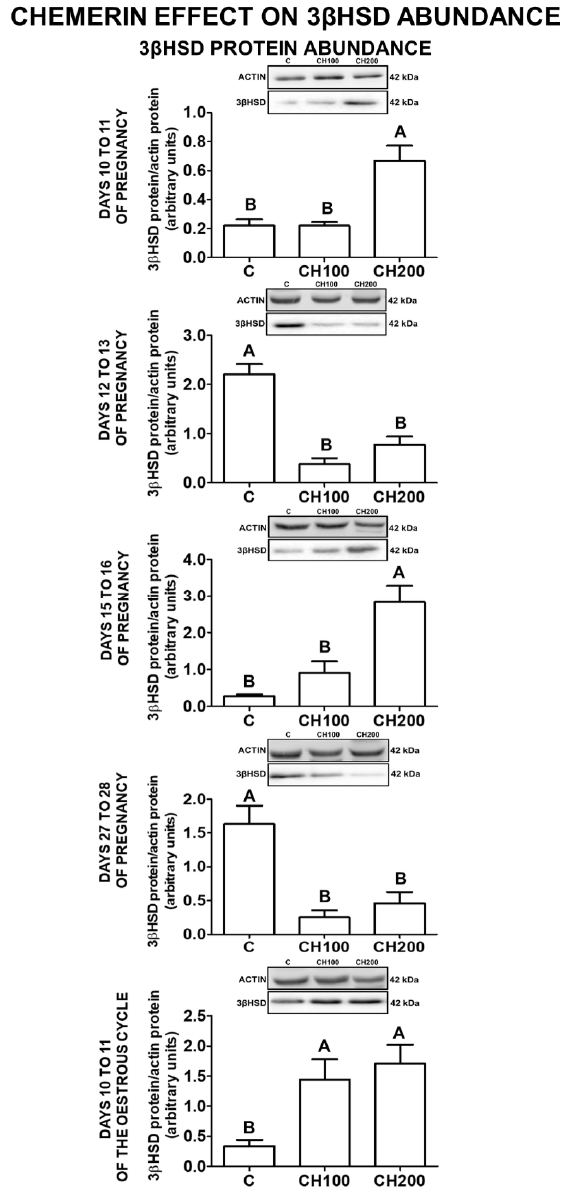
Figure 3. The effect of chemerin on 3 β HSD protein abundance. The influence of chemerin (100, 200 ng/mL) on the protein abundance of 3 β -hydroxysteroid dehydrogenase (3 β HSD) in the in-vitro- incubated endometrial tissue explants collected from pigs on days 10 to 11, 12 to 13, 15 to 16, and 27 to 28 of pregnancy, and on days 10 to 11 of the oestrous cycle. The protein abundance of 3 β HSD was evaluated using Western blot analysis. Upper panels—representative immunoblots, lower panels— densitometry analysis of target proteins’ relative content normalised with the actin protein. Data are presented as the mean ± standard error of the mean ( n = 5). Bars with different letters are significantly different at p < 0.05. C—control; CH100—chemerin 100 ng/mL; CH200—chemerin 200